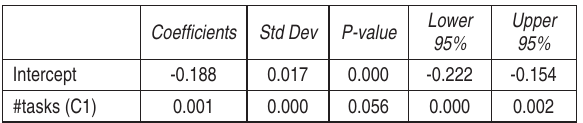
Table 4. Number of new developers (dependent var- iable) as a function of independent and control vari-